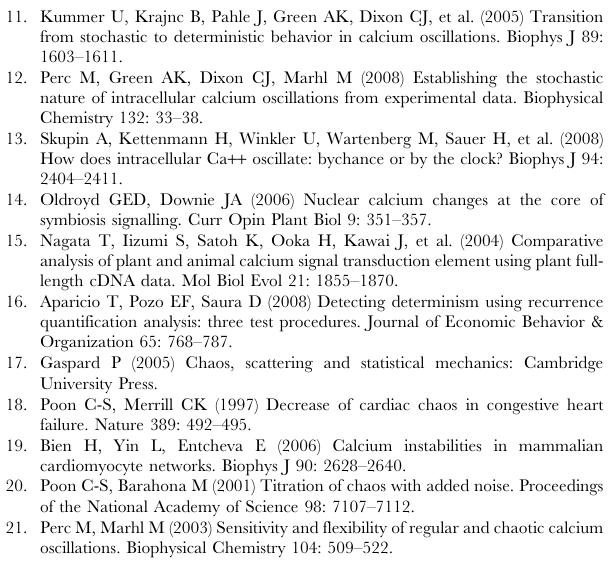
Figure S3 The Nod5 time series (black), after detrending with a moving average (blue) and after detrending using EMD (red). Y axis is a fluorescence ratio between Ca 2 + sensitive and Ca 2 + insensitive dyes. The detrended time series were truncated to obtain long, stationary segments. Found at: doi:10.1371/journal.pone.0006637.s005 (0.14 MB EPS) Figure S4 The Nod6 time series (black), after detrending with a moving average (blue) and after detrending using EMD (red). Y axis is a fluorescence ratio between Ca 2 + sensitive and Ca 2 + insensitive dyes. The detrended time series were truncated to obtain long, stationary segments. Found at: doi:10.1371/journal.pone.0006637.s006 (0.11 MB EPS) Figure S5 The Nod7 time series (black), after detrending with a moving average (blue) and after detrending using EMD (red). Y axis is a fluorescence ratio between Ca 2 + sensitive and Ca 2 + insensitive dyes. The detrended time series were truncated to obtain long, stationary segments. Figure S6 The Nod8 time series (black), after detrending with a moving average (blue) and after detrending using EMD (red). Y axis is a fluorescence ratio between Ca 2 + sensitive and Ca 2 + insensitive dyes. The detrended time series were truncated to obtain long, stationary segments. Figure S7 The Nod9 time series (black), after detrending with a moving average (blue) and after detrending using EMD (red). Y axis is a fluorescence ratio between Ca 2 + sensitive and Ca 2 + insensitive dyes. The detrended time series were truncated to obtain long, stationary segments. Figure S8 The Nod10 time series (black), after detrending with a moving average (blue) and after detrending using EMD (red). Y axis is a fluorescence ratio between Ca 2 + sensitive and Ca 2 + insensitive dyes. The detrended time series were truncated to obtain long, stationary segments.